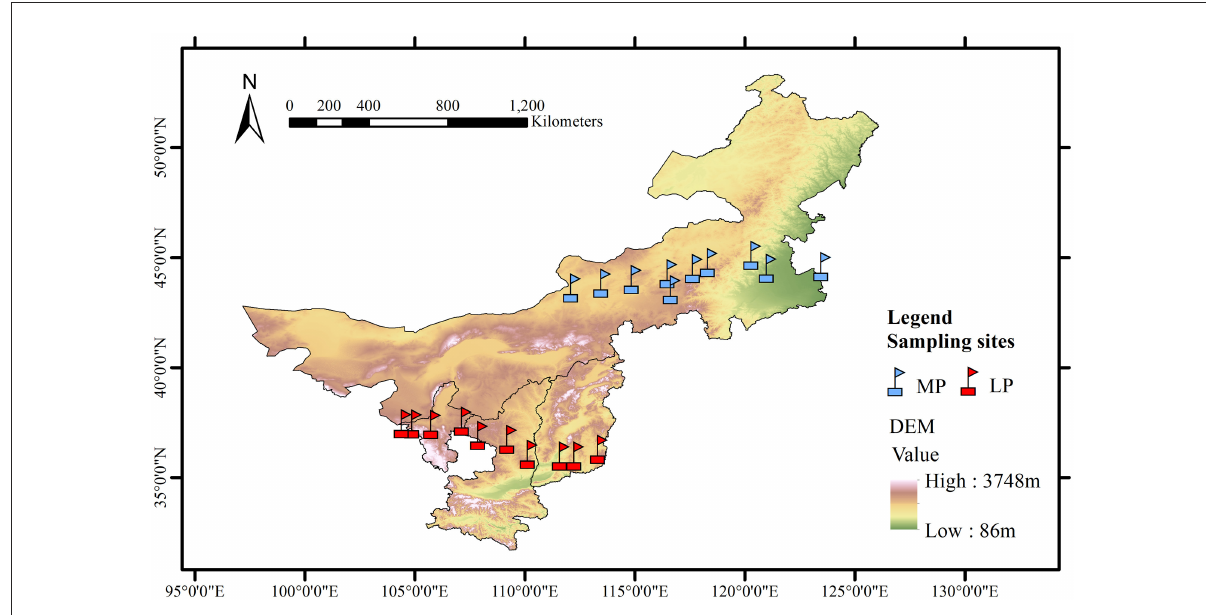
FIGURE1 Geographic characteristics of the grassland transects in Loess Plateau (LP) and Inner Mongolia Plateau